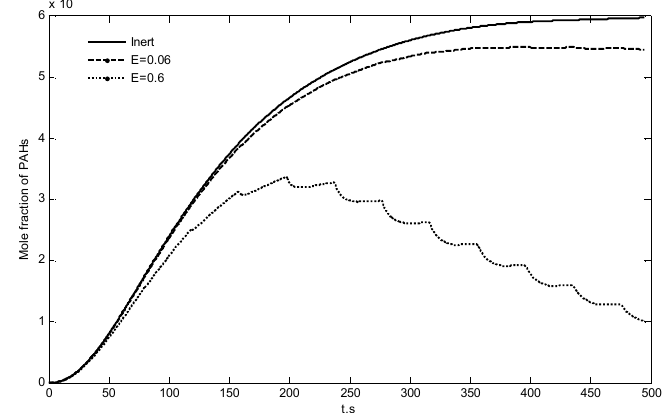
Figure 13. PAH formed at 1200 K by feeding C16H34 with molar fraction of 0.001 with different oxygen feeds: no oxygen in the feed; oxygen fed together with the fuel at partial pressure of 0.001 (E = 0.06); oxygen fed together with the fuel at partial pressure of 0.01 (E = 0.6).